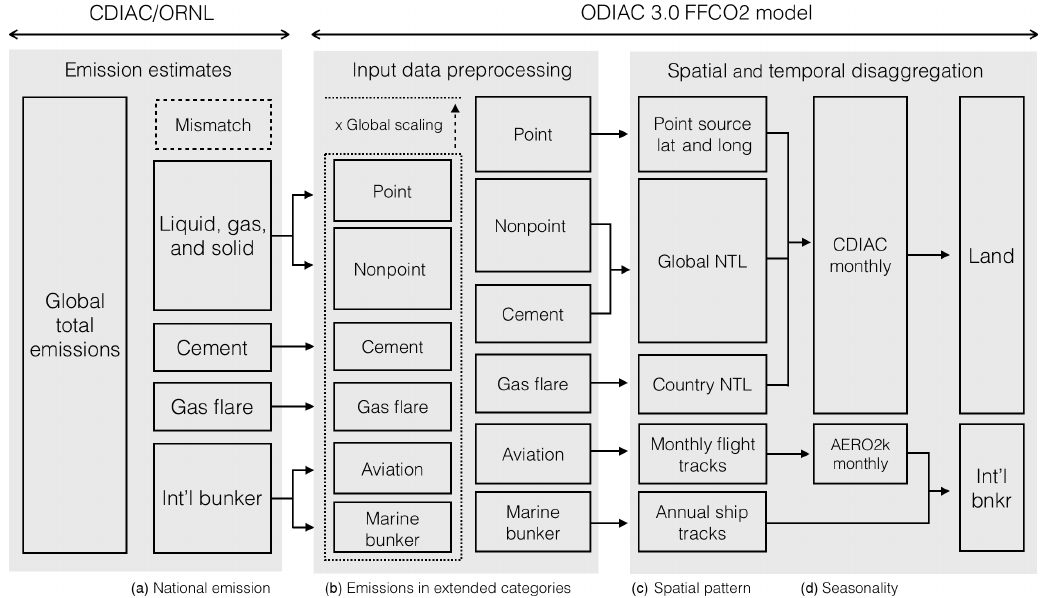
Figure 1. A schematic figure of the ODIAC emissions modeling framework (defined as “ODIAC 3.0 FFCO2 model”). Starting with CDIAC national emissions estimates made by fuel type (emissions estimates), the CDIAC national emissions estimates are first divided into extended ODIAC emissions categories (input data processing; see Sect. 3). The ODIAC 3.0 FFCO2 model then distributes the emissions in space and time, using point source geolocation information and spatial data depending on emissions categories such as nighttime light (NTL) and aircraft and ship fleet tracks (spatial disaggregation; see Sect. 4). The emissions seasonality for emissions over land and international aviation were adopted from existing emissions inventories (temporal disaggregation; see Sect.